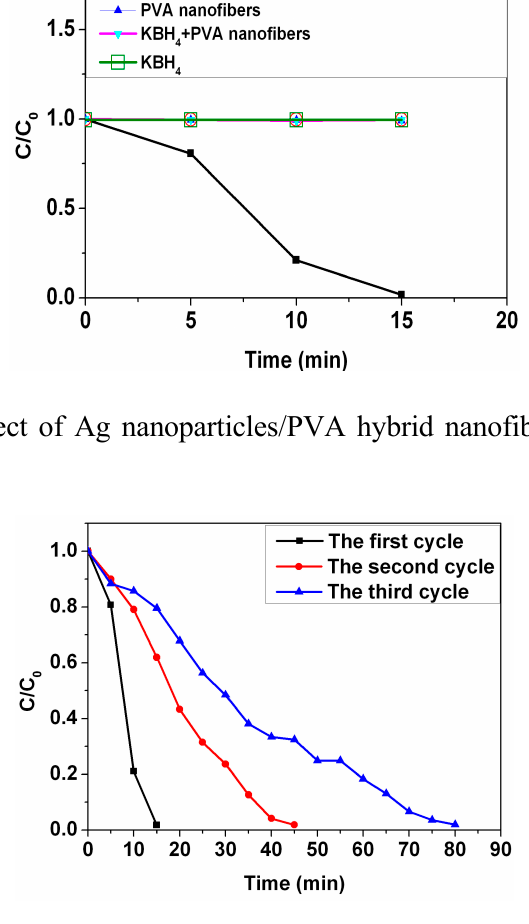
Figure 9. Catalytic kinetics Ag nanoparticles/PVA hybrid nanofibers for three successive reactions of